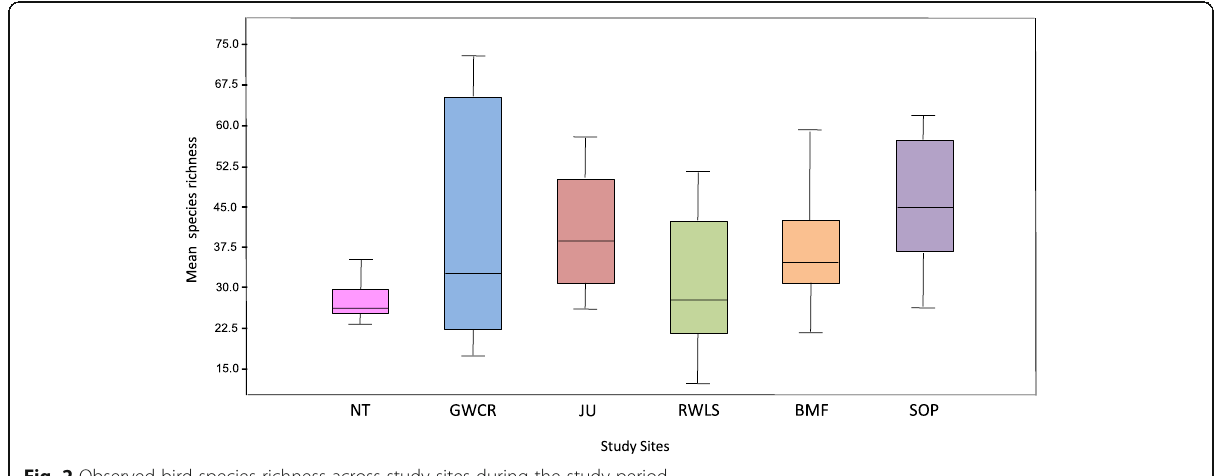
Fig. 2 Observed bird species richness across study sites during the study